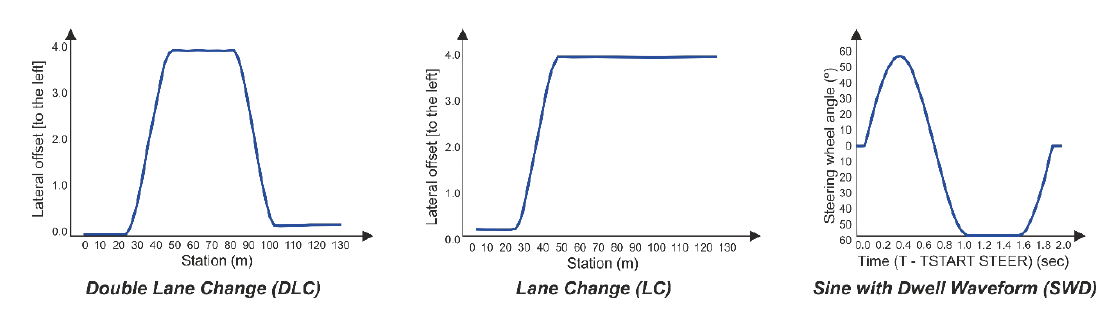
Figure 10. Lateral Figure 10. Lateral maneuvers.